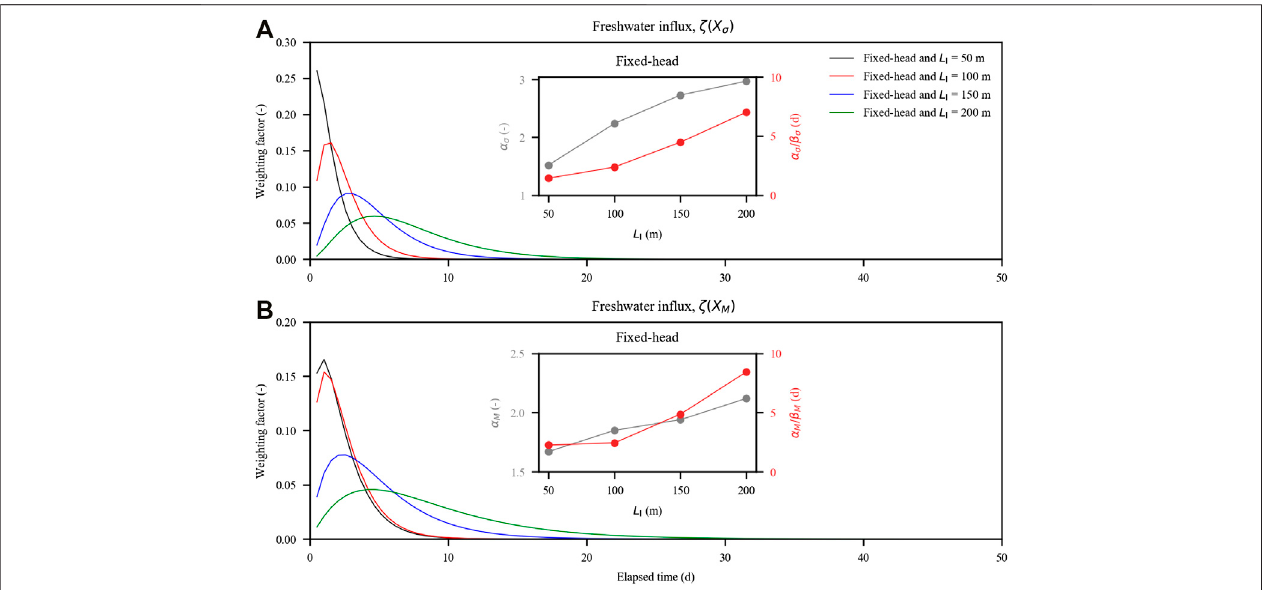
FIGURE 8 | Probability density functions of inland freshwater input quanti fi ed with the antecedent tidal conditions on the aquifer: (A) time-dependent weighting factorforthestandarddeviationoftidallevel( X σ )and (B) time-dependentweightingfactorfortheaveragedtidallevel( X M ).Theshapeandmeanparameters( α and α / β )of the Gamma distribution functions are given in the inserts.